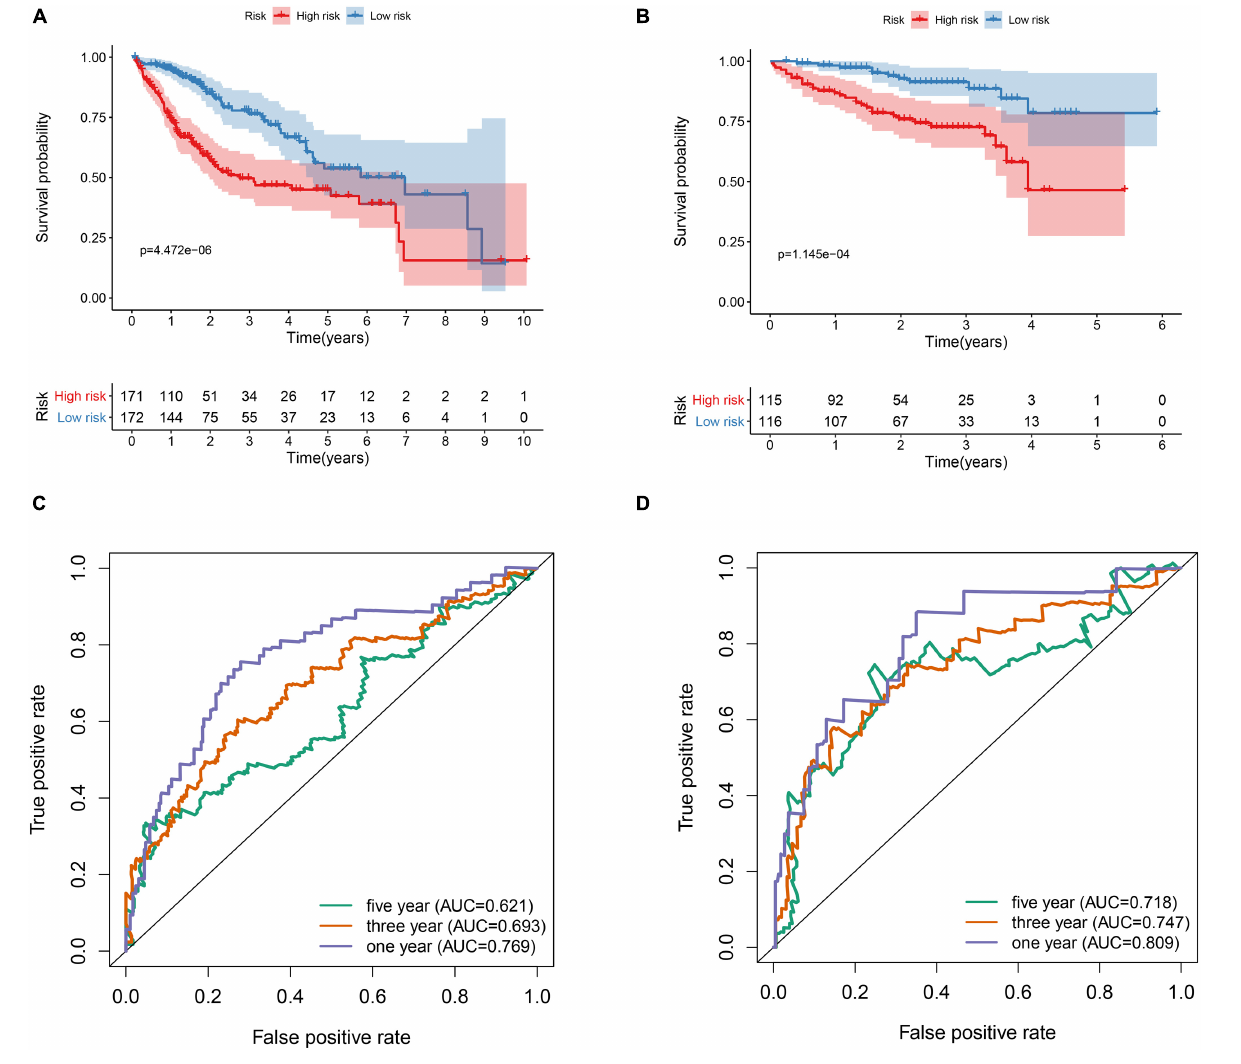
Frontiers in Genetics |